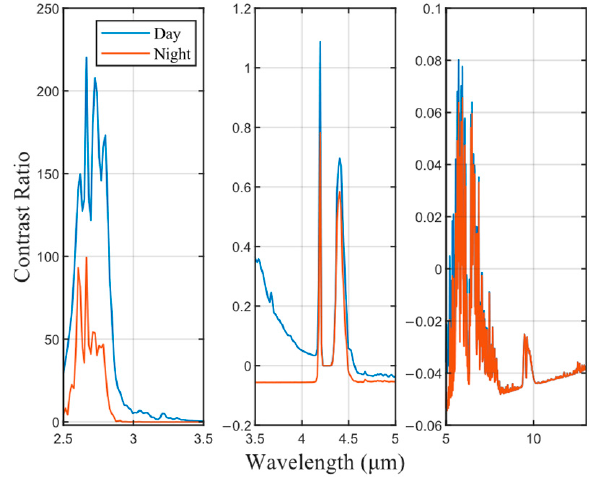
Figure 10. Comparison of target-background contrast ratio in daytime and nighttime.